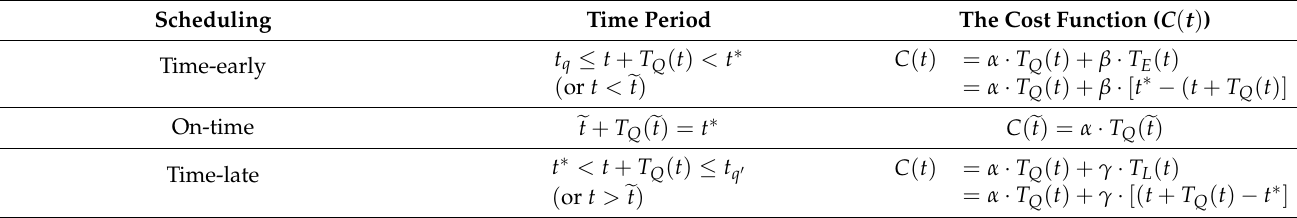
Table 1. The cost function for a ship with each of the three types of arrival pattern.